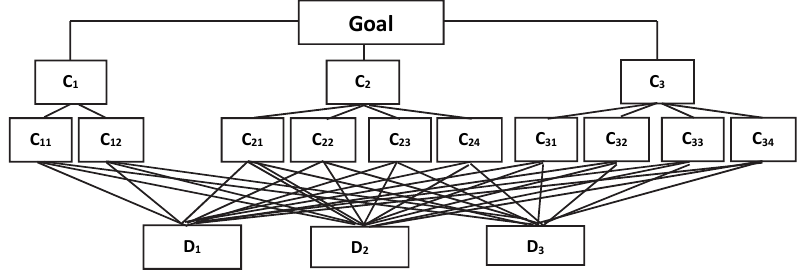
Fig.4. A multi-level hierarchy for evaluating the disposal locations for IWM